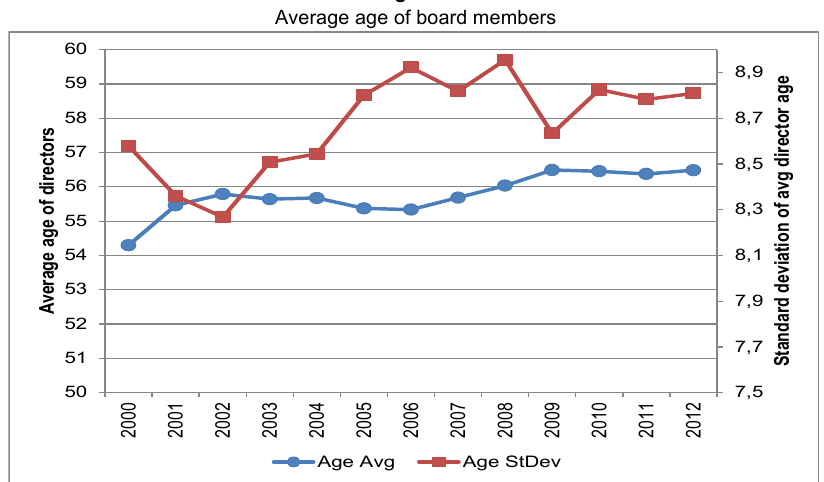
Figure 4 breaks the average board into decade age brackets for each year of the study period. It